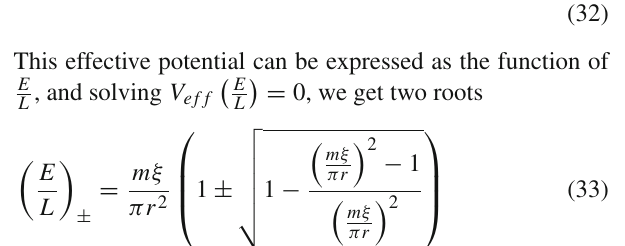
n 2 = 4 . 4 × 10 − 7 cm 2 / W , the wavelength λ = 532 nm , the pump power P = 252 mW , the value of the pump waist = 1 cm , the pump orbital angular momentum (OAM) ω bg l = 1, and the signal OAM s = 2. The pump intensity is got- √ , healing length ξ = λ/ 4 n 0 | n 2 | ρ 0 , ten as I = ρ 0 = P /ω 2 (cid:10) bg c 2 | n 2 | ρ 0 / n 3 , the flow speed the speed of sound c s = 0 = s − l . v θ = c | m | / n 0 kr , and m In the upper panel of Fig.4, the superradiance forbidden region inside the ergosphere is given with the red shadow, which is near the static limit. The angular momentum forbid- den region is presented in the lower panel of Fig.4, and the forbidden region inside the ergosphere is also near the